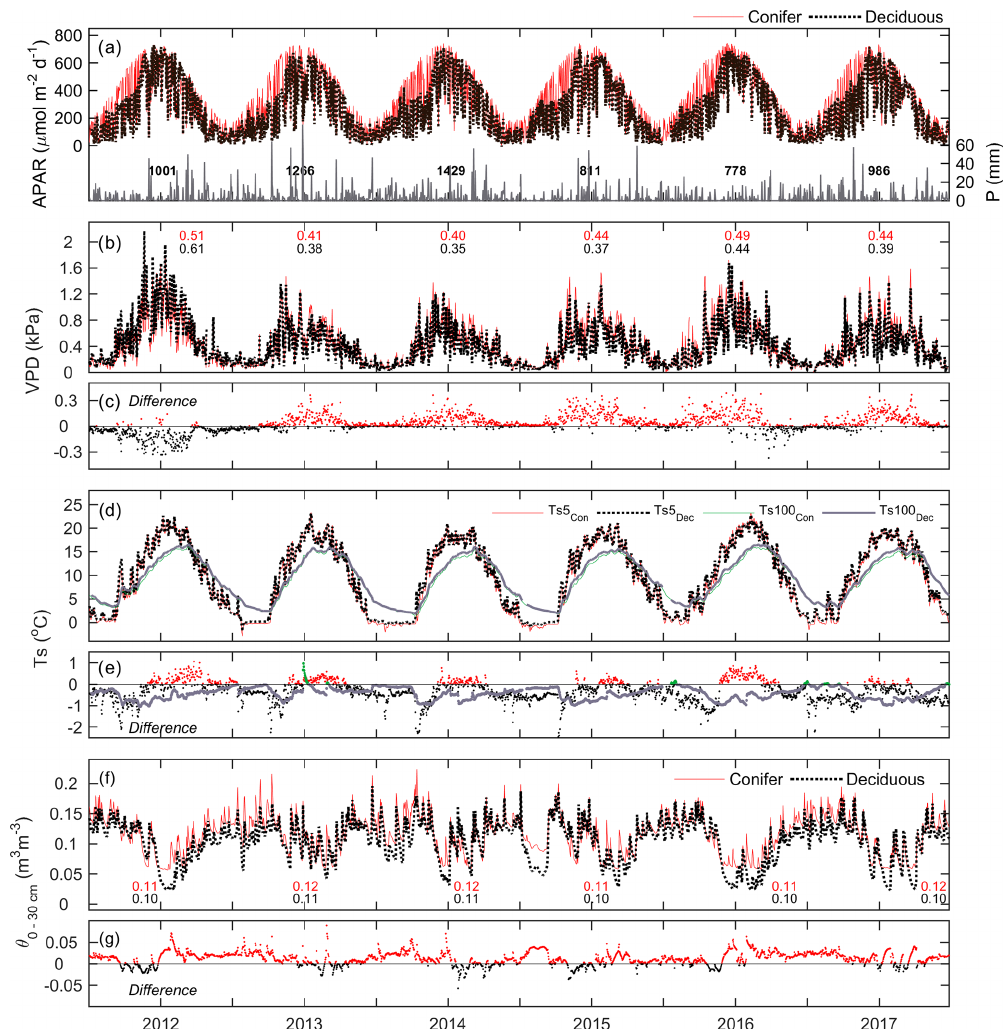
Figure 2. Time series of daily mean meteorological variables measured at the conifer (TP39, red line) and deciduous (TPD, black dashed line) forests from 2012 to 2017, including ( a , left) absorbed photosynthetically active radiation (APAR), ( a , right) total precipitation ( P ), (b) vapor pressure deficit (VPD), (c) the difference in VPD between the two forests (conifer – deciduous), (d) soil temperatures ( T s ) at 5 and 100cm depths, (e) the difference in T s between the two forests at both depths, (f) soil volumetric water content from 0–30cm depths ( θ 0–30cm ), and (g) the difference in θ between the two